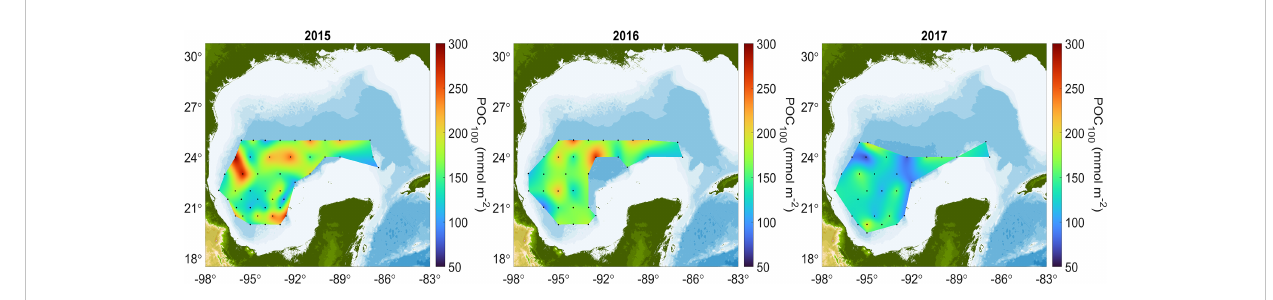
FIGURE 6 Integrated particulate organic carbon concentrations for the fi rst 100 m (POC 100